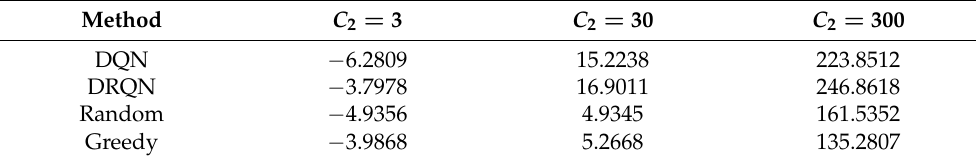
Table 4. The reward after 200,000 steps under different C 2 (multiple SUs).